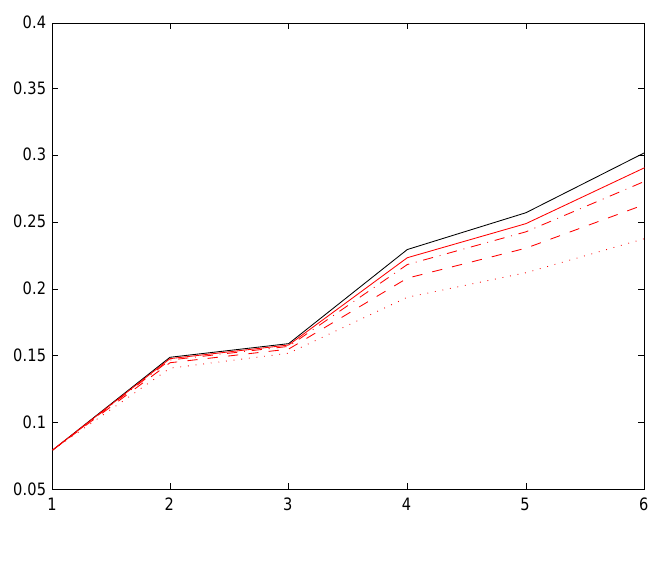
Figure 2. Convergence of relativities,